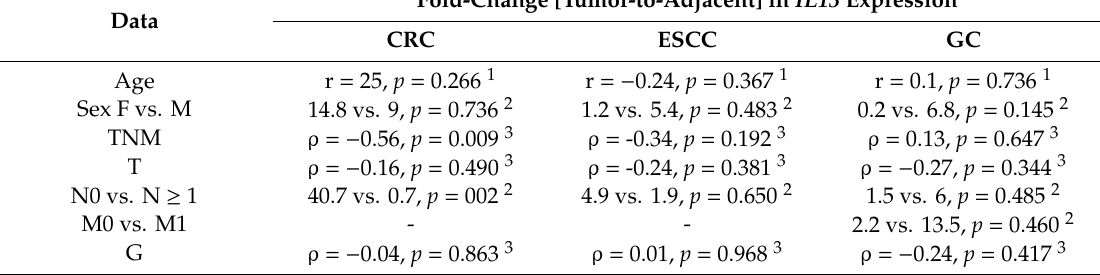
Table 7. Association of demographic and pathological data with IL13 expression in the GIT cancer